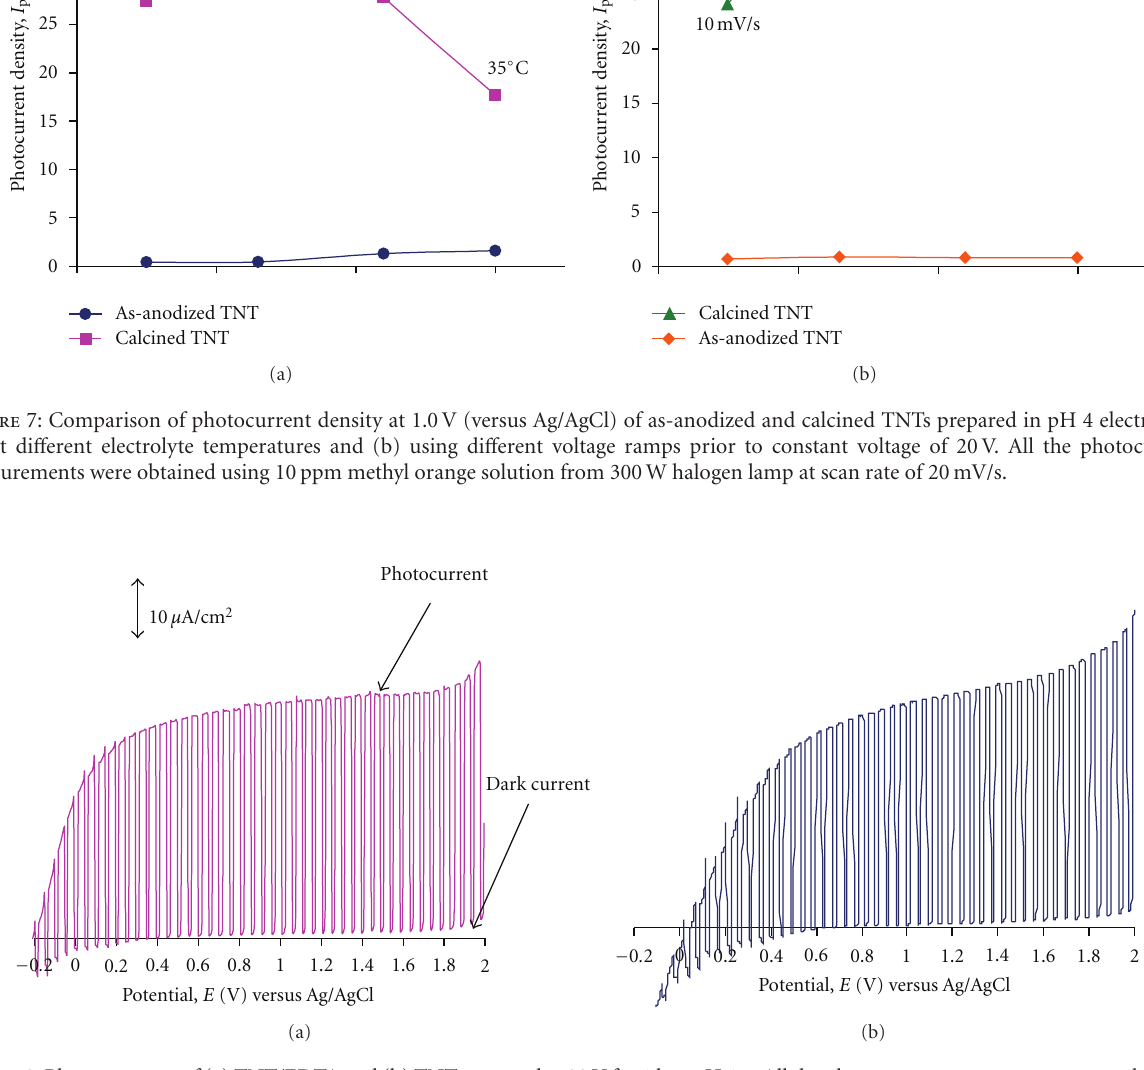
wall, photogenerated hole could reach the oxidizable species in the electrolyte easily and reducing the